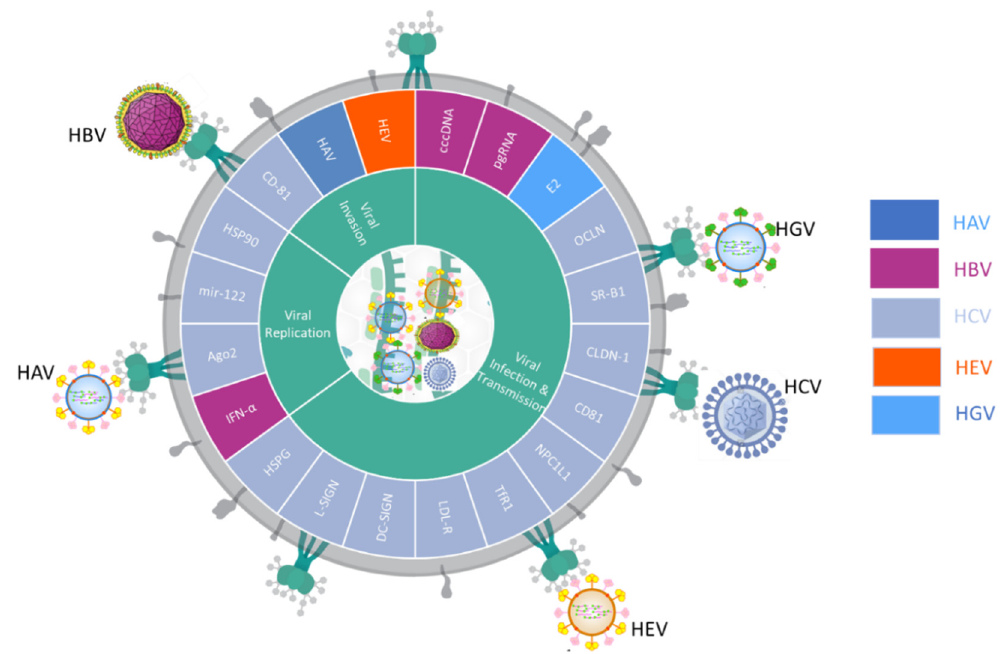
Figure 1. Summary of the viral liquid biopsy markers driven by hepatitis viruses in the pathogenesis of viral hepatitis. Classification of viral related liquid biopsies by viral infection and transmission, viral replication, and viral invasion on the HAV ( █ ), HBV( █ ), HCV( █ ), HEV( █ ), and HGV( █ ).